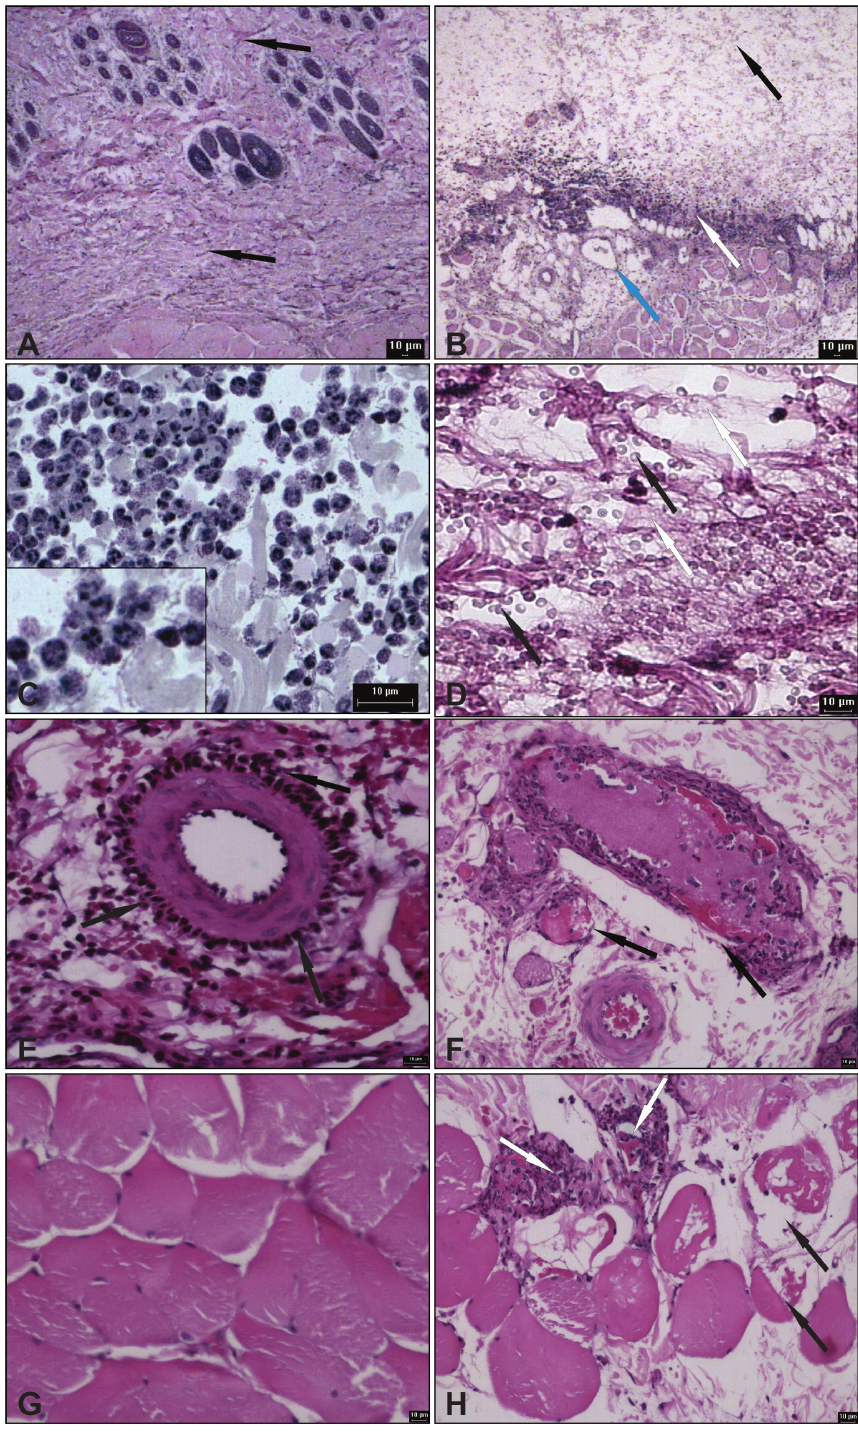
Figure 2. Microscopic picture of rabbit skin: ( A ) control group – the black arrow indicates the integrity of the collagen fibers; ( B ) experimental group – note the dissociation of fibers and cells characterizing edema (black arrows), angiectasis (blue arrow), intense inflammatory infiltrate, predominantly heterophilic (white arrow); ( C ) details of the inflammatory infiltrate (methacrylate, semi-thin section); ( D ) experimental group – fibrin deposition (white arrows) and hemorrhage (black arrow); ( E ) perivascular cuff observed 6 hours after venom injection (black arrows), ( F ) occluding thrombus (black arrows), ( G ) control group – cutaneous muscle; ( H ) experimental group – necrosis of the cutaneous muscle (white arrow) and heterophilic infiltration (black arrow). Staining: A, B, C, E and F = HE; D = PAS counter-stained with hematoxylin. Bar = 10